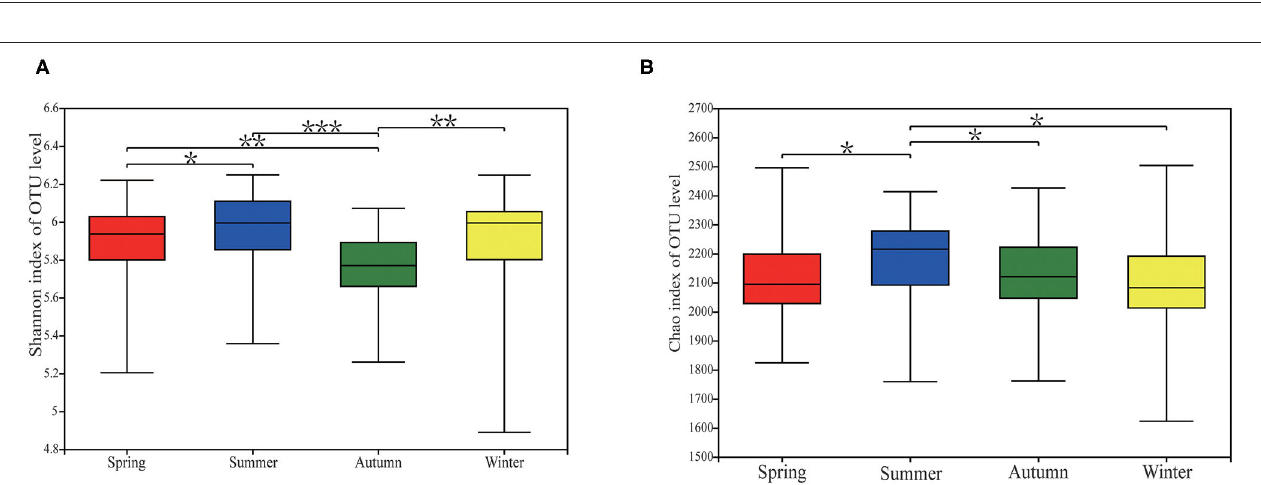
FIGURE 1 | Rarefaction curves and Venn diagram. (A) Rarefaction curves of gut microbial communities. The rarefaction curve was drawn with the amount of extracted data as the abscissa and the coverage index value as the ordinate. (B) OTU Venn diagram in different seasons.